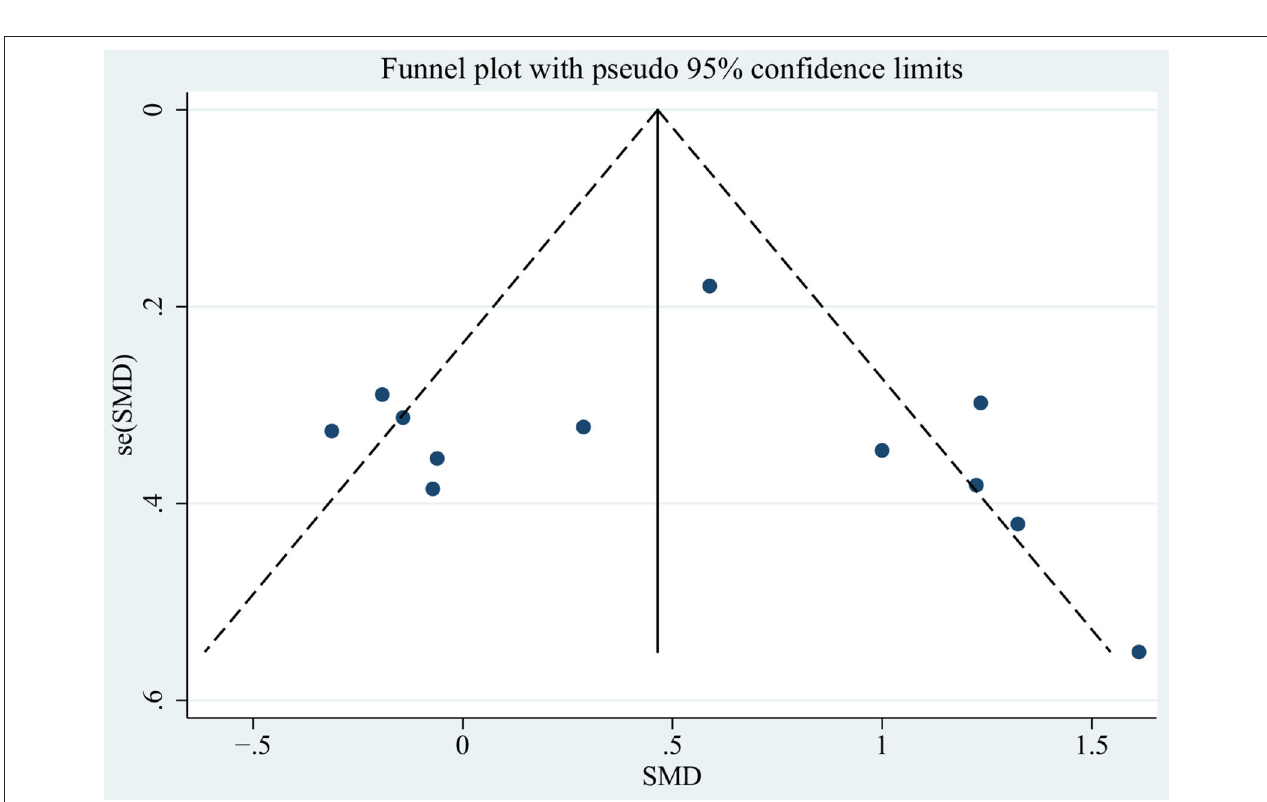
FIGURE 10 | Funnel plot for the assessment of publication